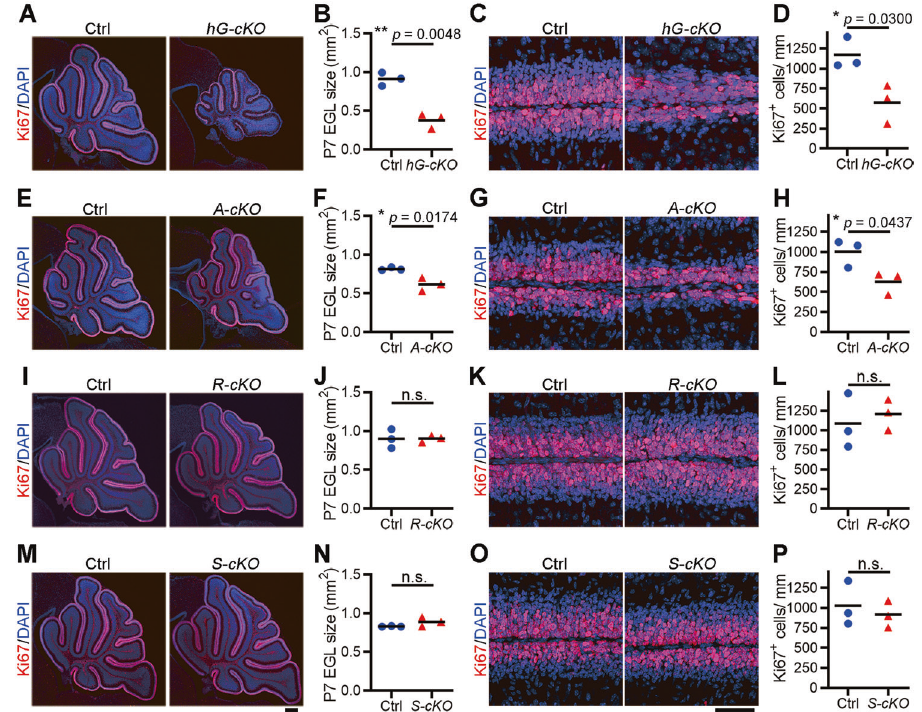
Fig. 2 Wdr4 ablation impairs GNP proliferation in a cell-autonomous manner. A – P Representative confocal images and quantitative data from the whole cerebellar section ( A , B , E , F , I , J , M , N ), and the EGL of lobule V – VI ( C , D , G , H , K , L , O , P ) showing EGL size and Ki67 + proliferating GNPs in the indicated Wdr4 conditional knockout and control mice at P7 (scale bars, 250 μ m in the left and 50 μ m in the right). Data were from 3 cerebella in each group and analyzed using a two-tailed unpaired Student ’ s t -test without Welch ’ s correction (equal variances, B , D , F , H , J , L , P ) or with Welch ’ s correction (unequal variances, N ), p = 0.0048 in ( B ), 0.0300 in ( D ), 0.0174 in ( F ), 0.0437 in ( H ), 0.9848 in ( J ), 0.6309 in ( L ), 0.2248 in ( N ), and 0.5906 in ( P ). Data are represented as individual points and mean; * p < 0.05, ** p < 0.005; n.s., non- signi fi cant. See also Figs. S2 –